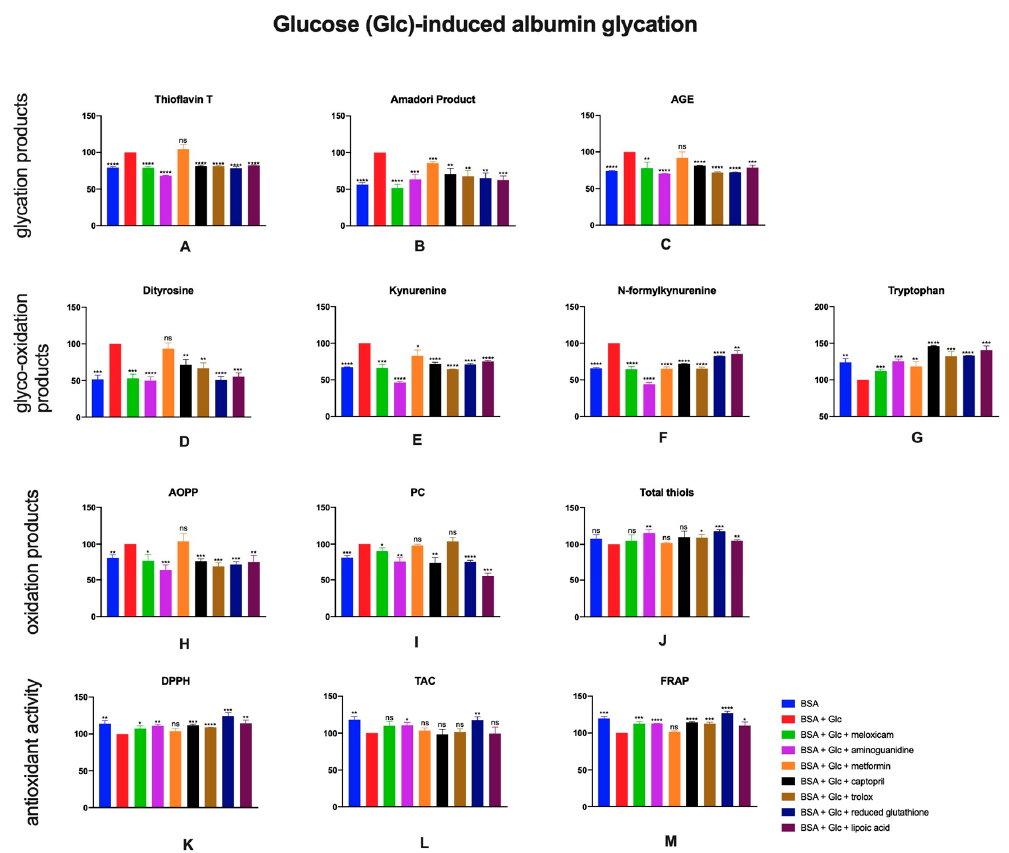
Figure 2. The effects of meloxicam, captopril, trolox, reduced glutathione, lipoic acid,